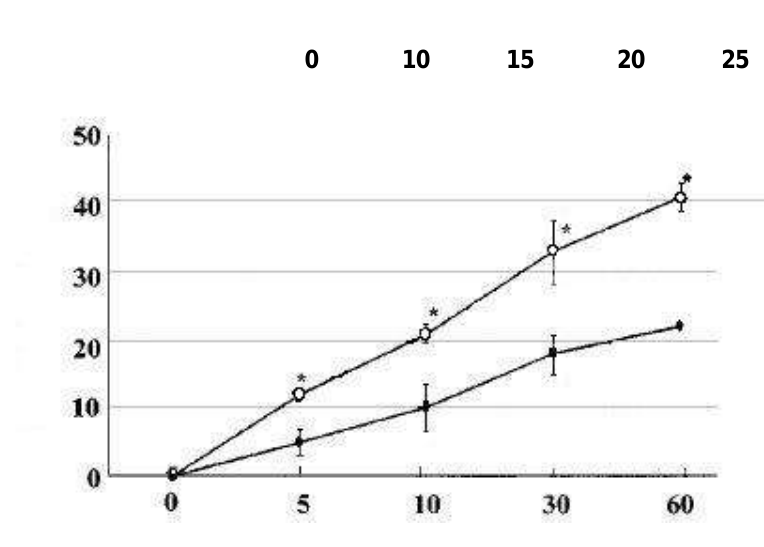
Figure 2 : Potentiation of relaxation in epithelium denuded sheep trachea. The tracheal rings were relaxed in an exposure-dose dependent manner. The results are measured as peak amplitudes and expressed as percentages of the acetylcholine-induced contraction in the same rings. Values represent the means of 6 separated ± SE experiments performed. w/epi represents the epithelium present and w/o epi represents the epithelium denuded sheep trachea . * P<0.01 vs. w/epi and w/o epi of